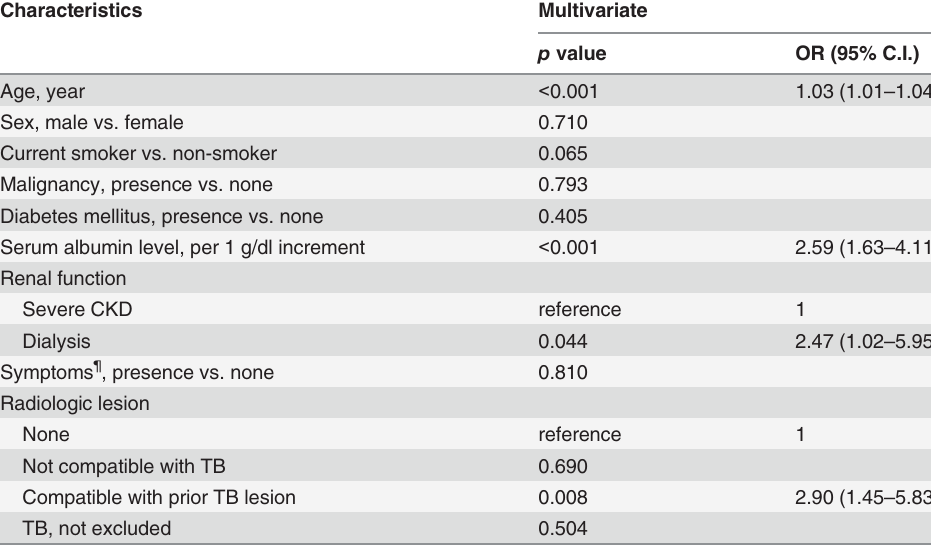
Table 2. Multivariate logistic regression for predicting positive interferon-gamma release assay among patients with severe CKD or those undergoing dialysis. Characteristics Multivariate p value OR (95% C.I.) Age, year <